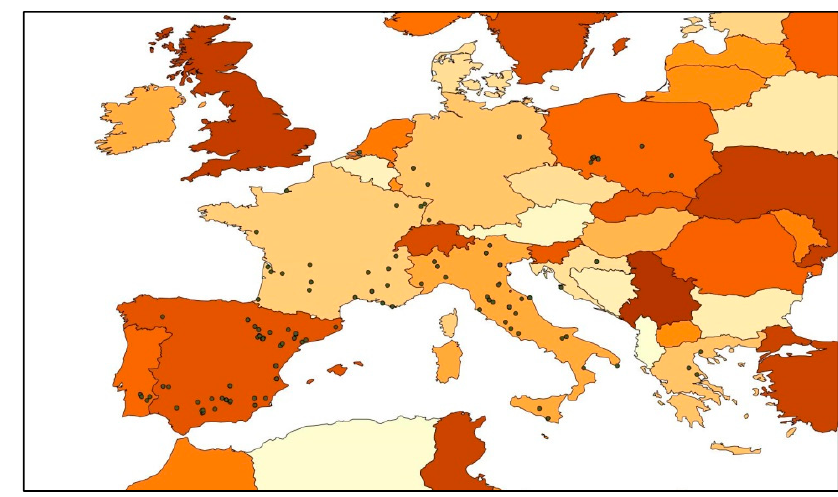
Figure 3. Location of database records in Europe.